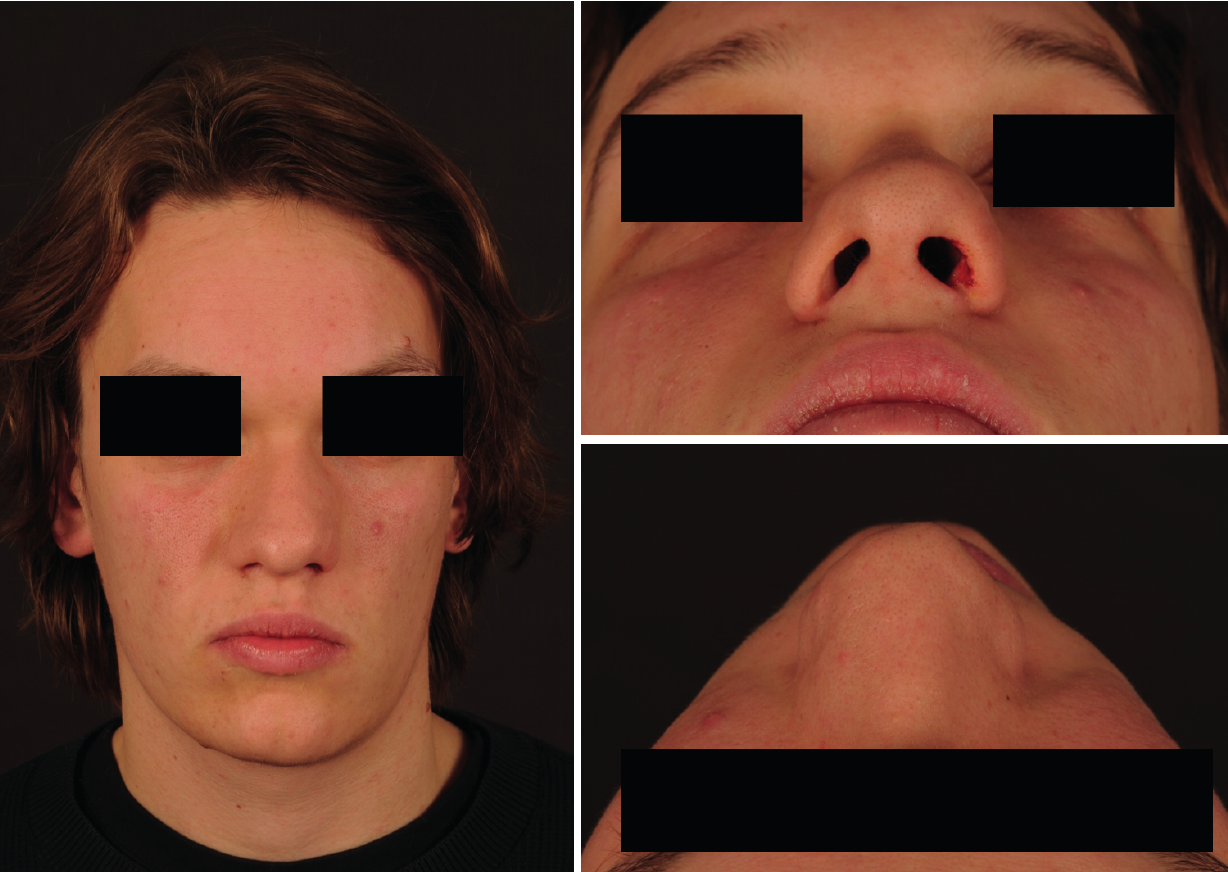
Figure 1. Clinical images taken at the time of presentation. A swelling of the left lateral side of the nose is visible.